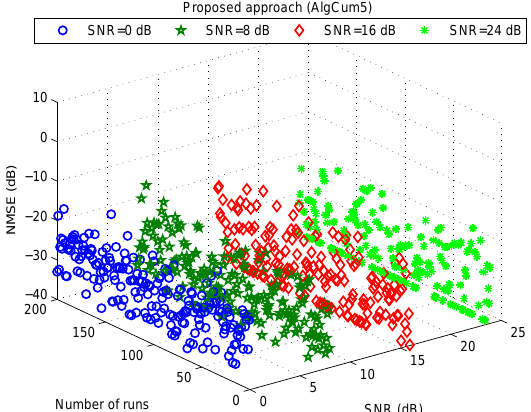
Figure 6. Behavior of the distributions of estimated NMSE using the proposed approach (AlgCum5) in system